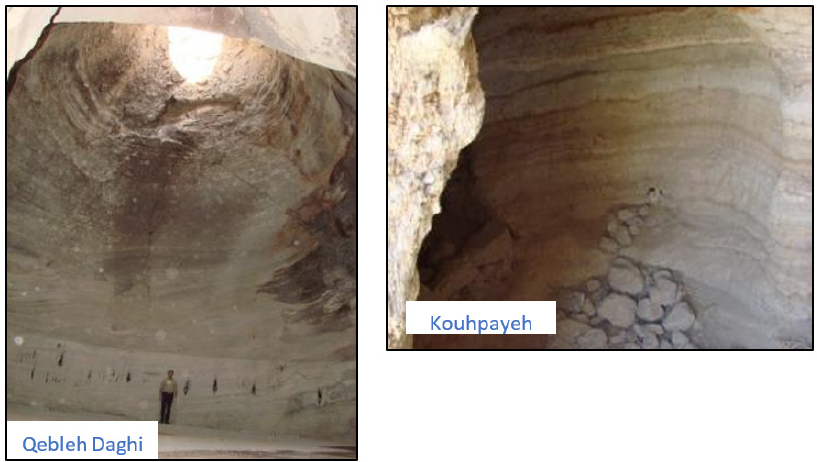
Figure 11. Horizontal arrangement of layers in pyroclastic context of Qebleh Daghi of Azarshahr and sedimentary context of